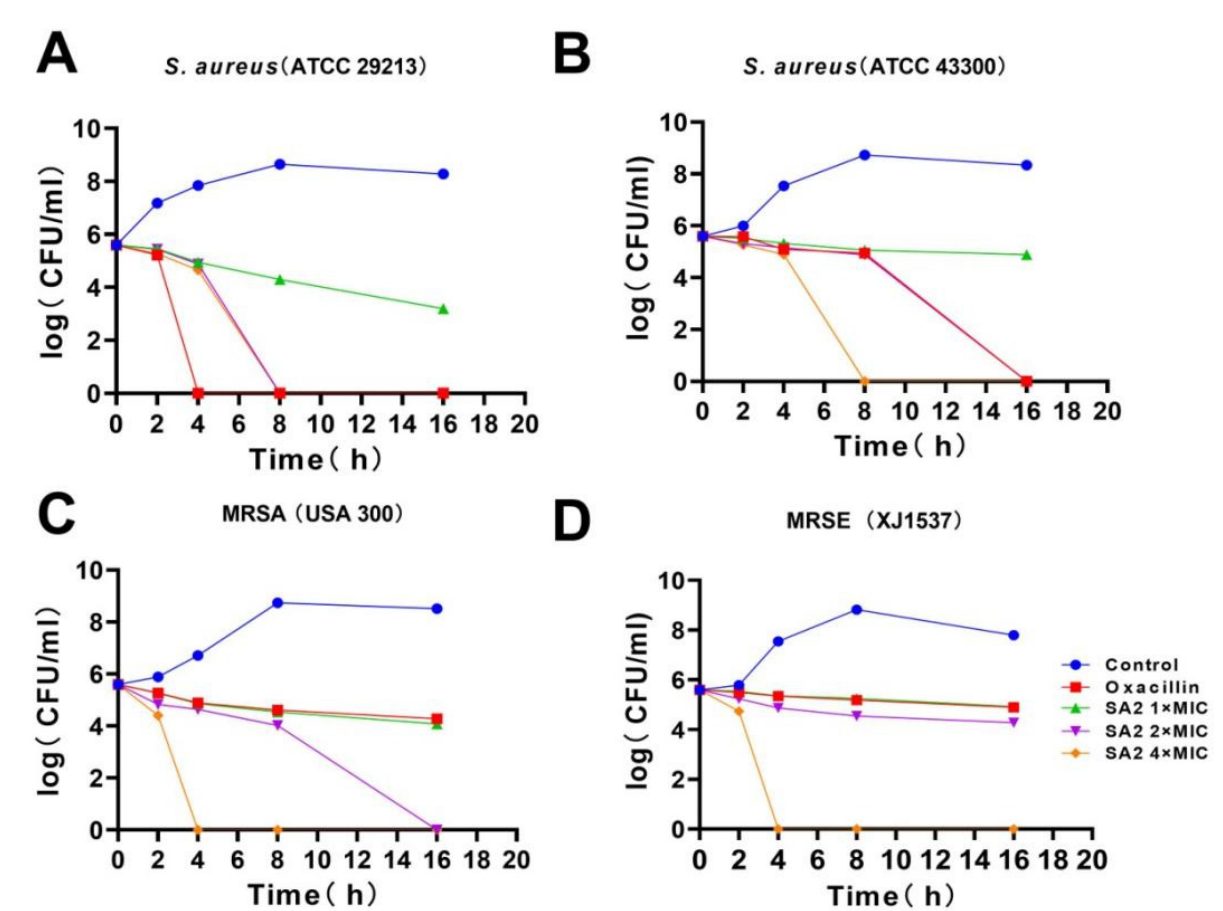
Figure 2. The bactericide of SA2 to S. aureus and S. epidermidis . The colony formation unit (CFU) of S. aureus ATCC 29213 ( A ), S. aureus ATCC 29213 ( B ), MRSA USA300 ( C ), and MRSE (XJ1537) ( D ) were decreased after SA2 treatment within 4–8 h at concentrations of 2× and 4× MIC.